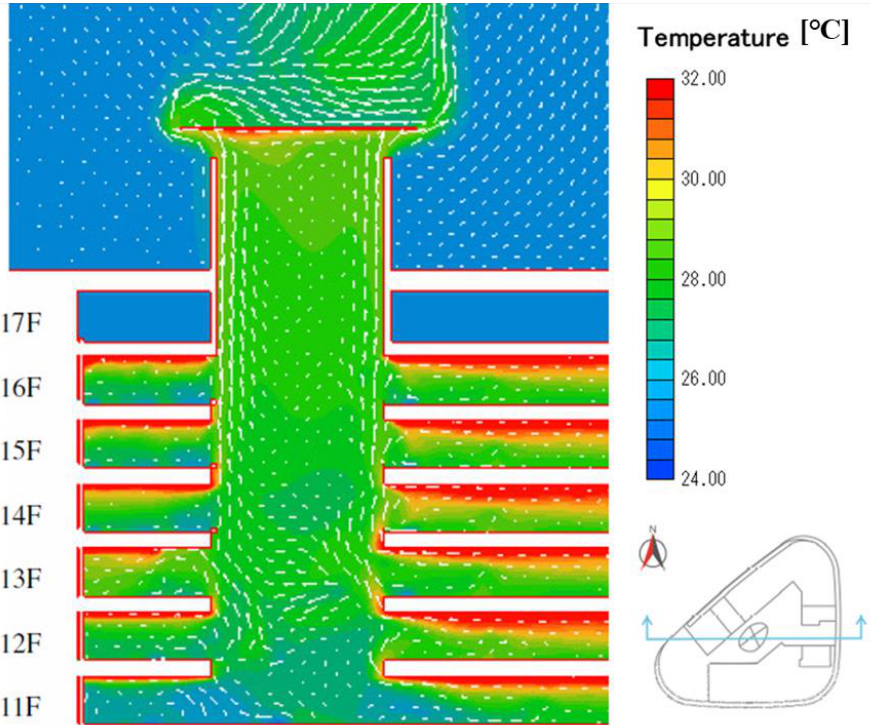
Figure 16. Temperature distribution in atrium with low SA height (0.4 m).